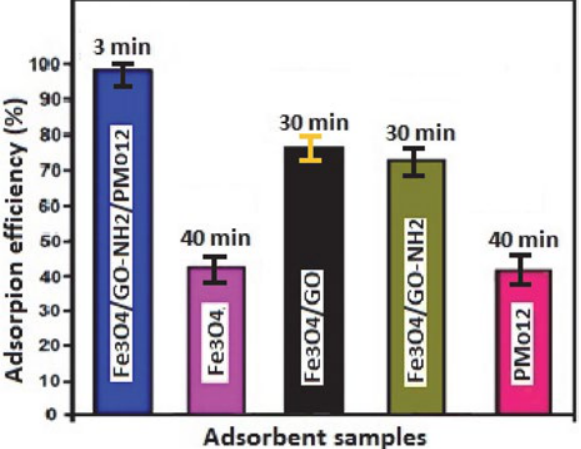
Figure 11. Adsorption efficiency (%) of the MB dye in the pres- ence of different adsorbent